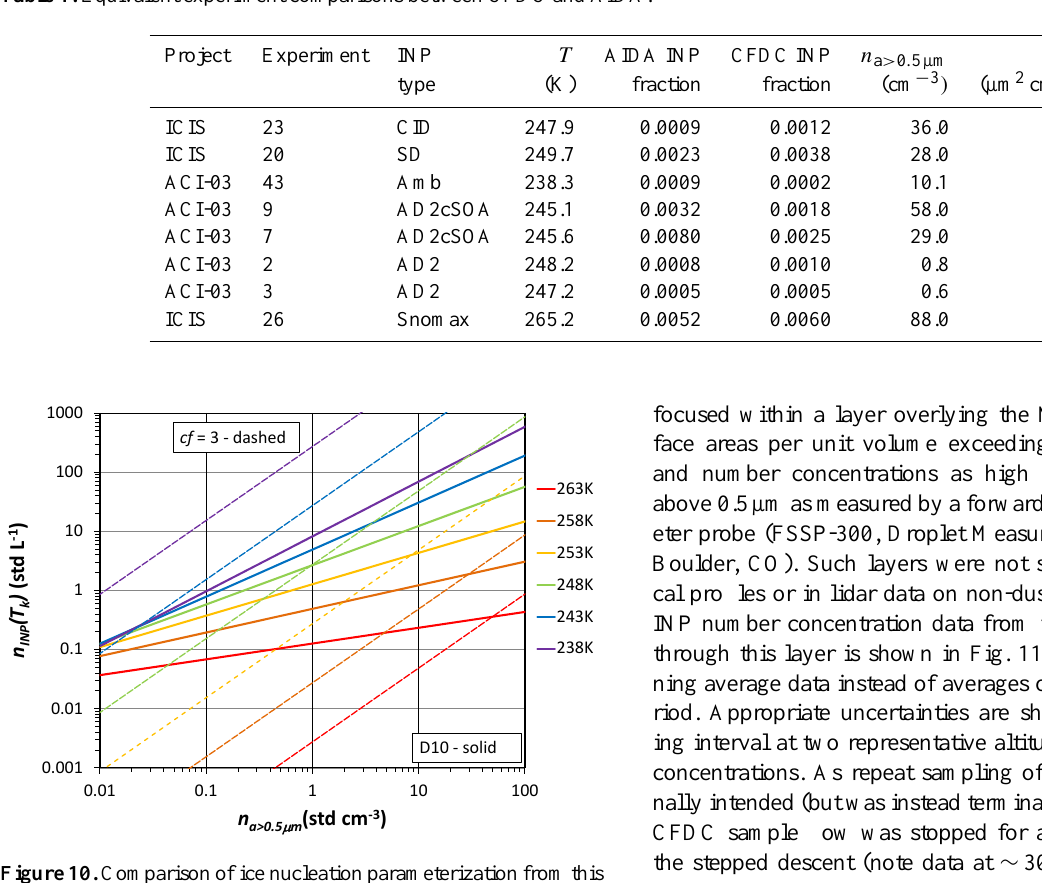
Figure 10. Comparison of ice nucleation parameterization from this study (Eq. 2 with cf = 3), with the D10 parameterization for calcu- lations in the mixed-phase cloud